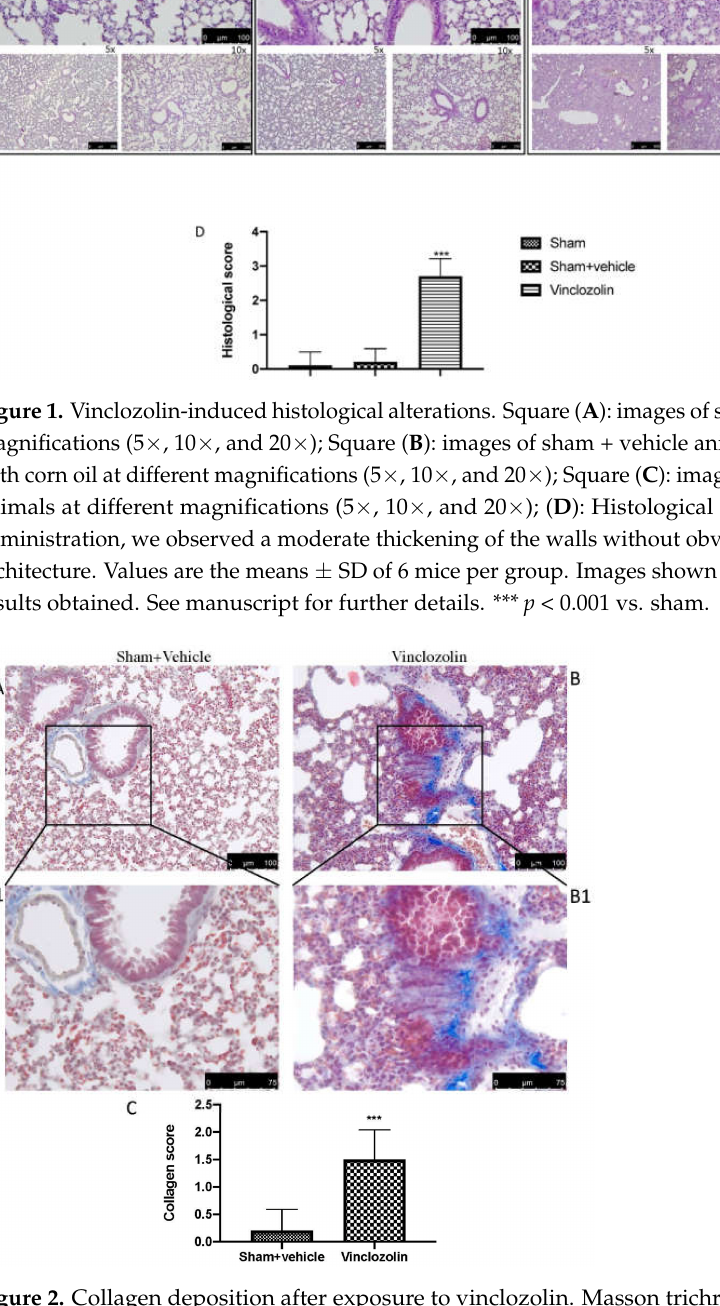
Figure 2. Collagen deposition after exposure to vinclozolin. Masson trichrome staining results for sham ( A , A1 ) and for vinclozolin-treated ( B , B1 ) animals; collagen score ( C ). Values are the means ± SD of 6 mice per group. Images shown are representative of the results obtained. After vinclozolin exposure, we found a significant increase in collagen deposition as shown by the increase in blue staining. *** p < 0.001 vs.